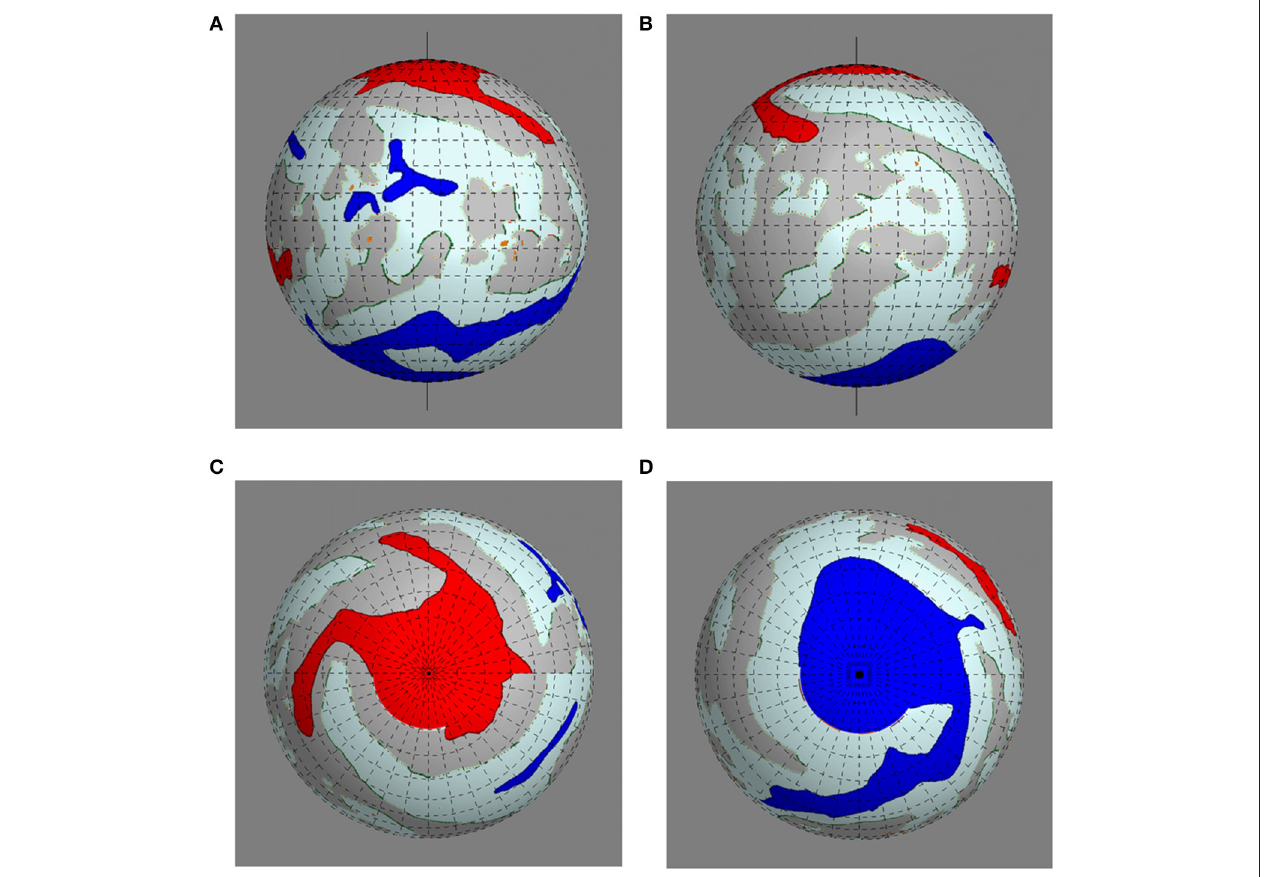
FIGURE 8 | An example of the transformation of the Mercator-type rectangular McA synoptic maps into a spherical coordinate system. In this coordinate system, the data for each CR appears on a rotating sphere and can be viewed from different vantage points. This is illustrated for one CR (1728) showing the two side-on views 180 ◦ apart centered on the equator and at (A) 45 ◦ and (B) 225 ◦ Carrington longitudes plus (C) north and (D) south polar views, respectively. Movies 3 - 6 of these same four views for the final, Level 3 McA data set are provided in the Supplemental Material.